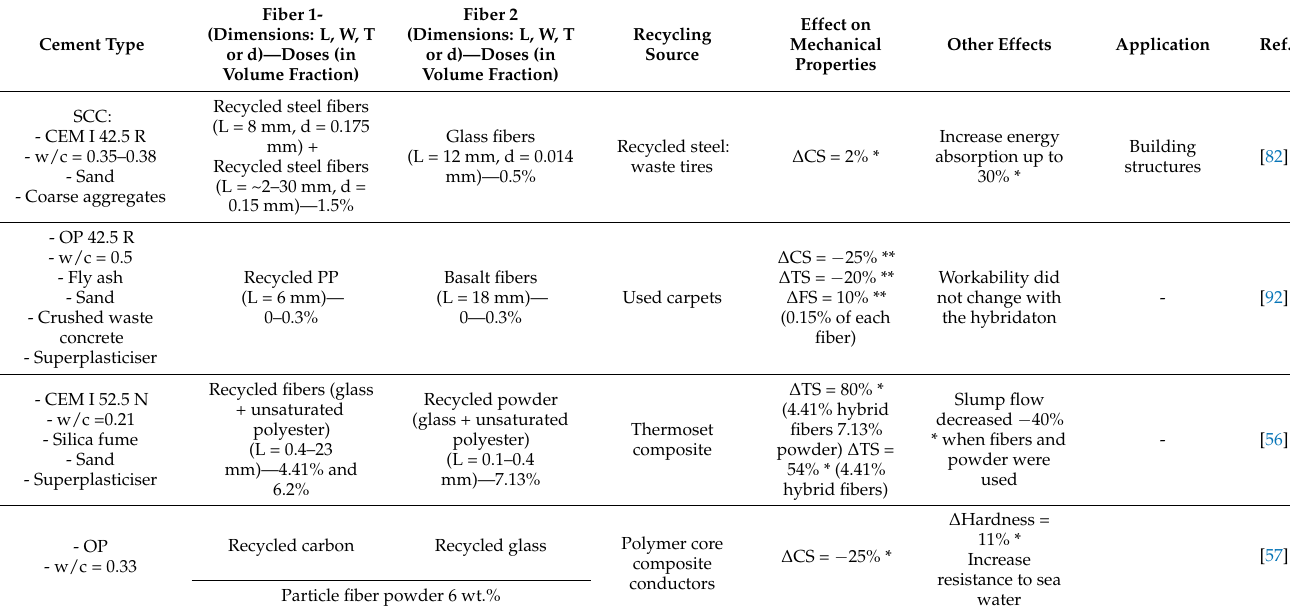
Table 6. Complex hybrid R-FRC containing other recycled material.